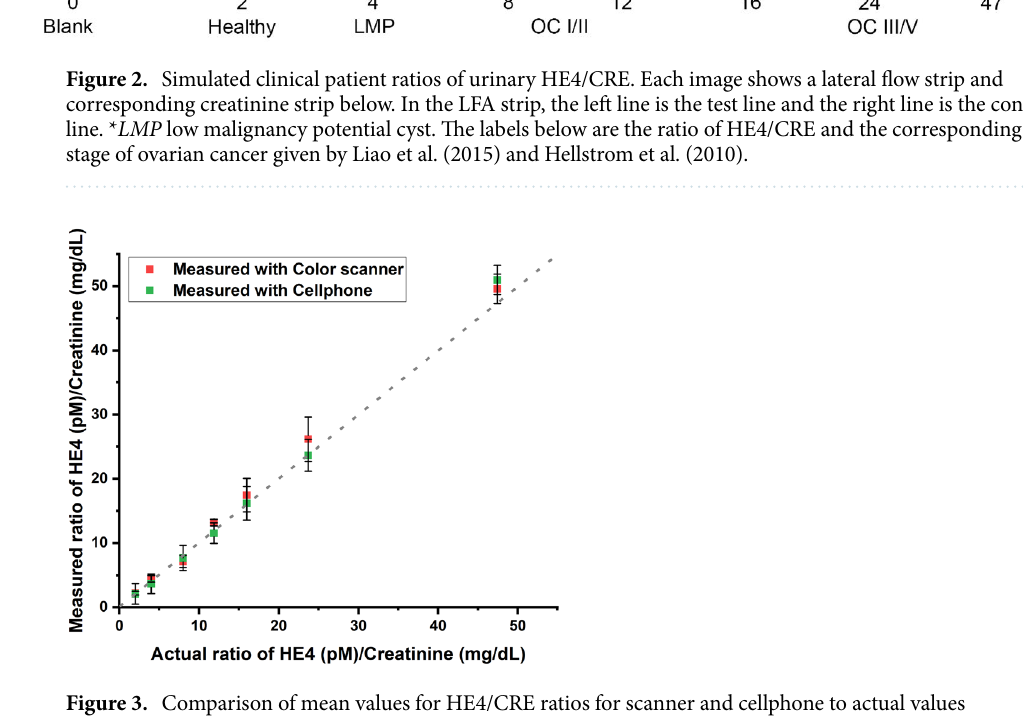
Figure 3. Comparison of mean values for HE4/CRE ratios for scanner and cellphone to actual values (mean + s.d, n = 5 ). The dotted line indicates the line of